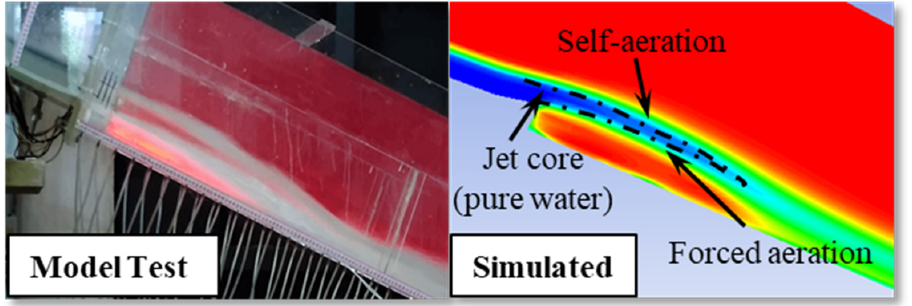
Figure 10. Water tongue and air entrainment behind aerator no. 1.